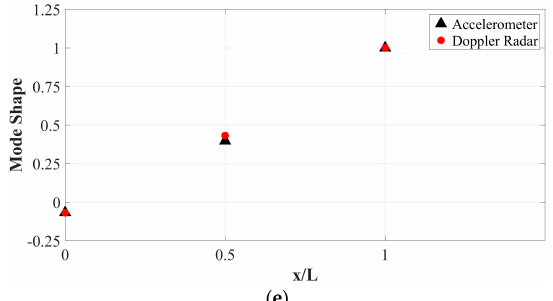
Figure 11. Experimental results: ( a ) demodulated displacement using the AJSPA retrieved at the tip of the mast; ( b ) demodulated displacement recovered at the midspan; ( c ) instantaneous dominant frequencies at the tip; ( d ) instantaneous dominant frequencies at the midspan; ( e ) first in-plane mode shape of the traffic light structure evaluated by the Doppler radar array and an accelerometer attached to the pole-arm connection [72].